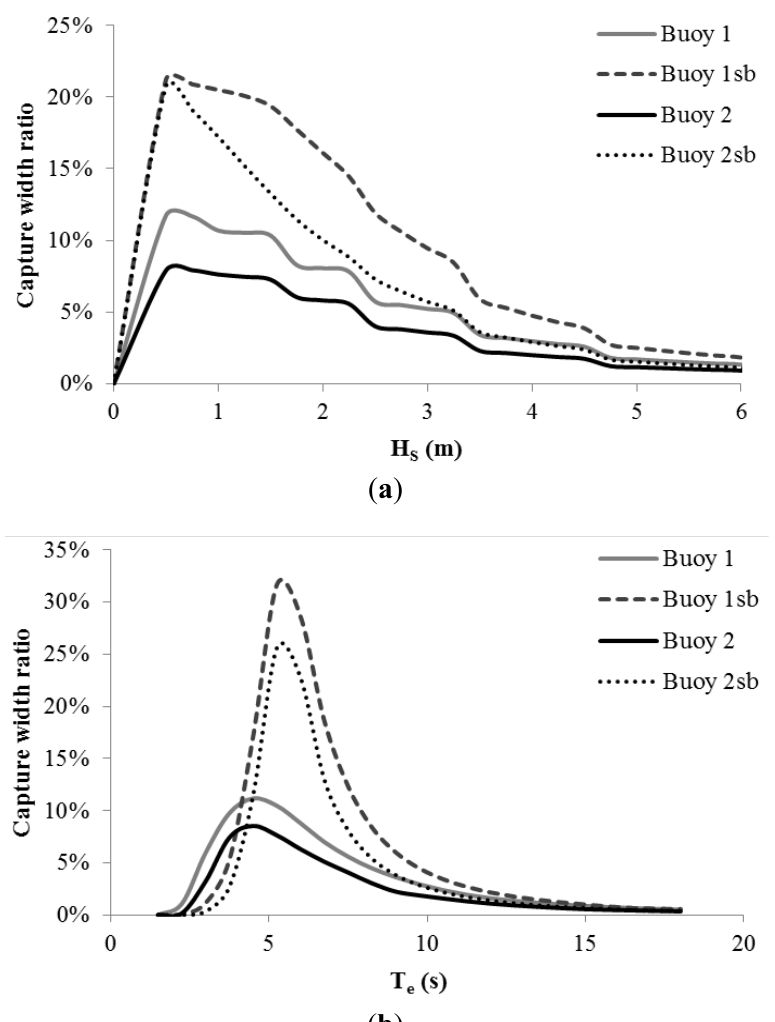
Figure 5. Capture width ratio of the buoy configurations as a function of ( a ) significant wave height and ( b ) energy